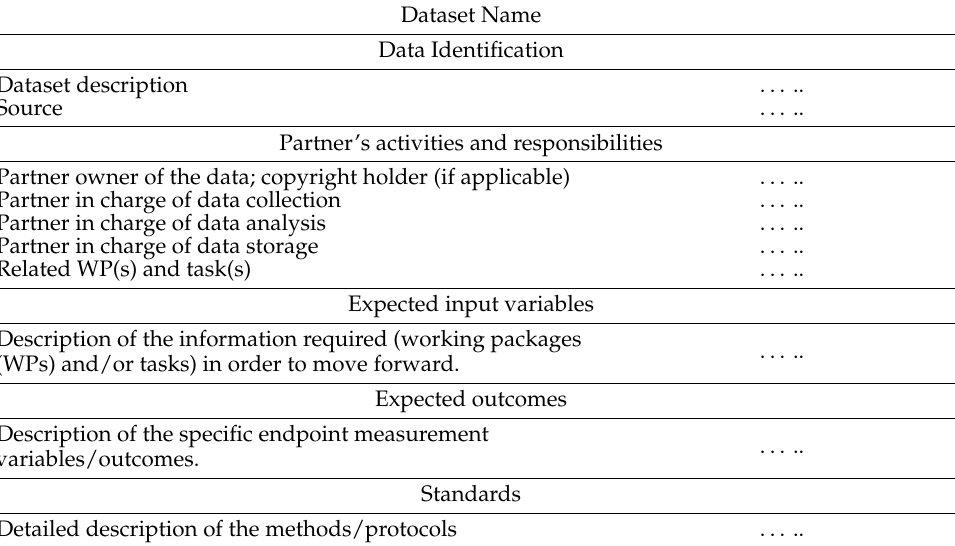
Table 1. Form for collection of information on each dataset from the relevant